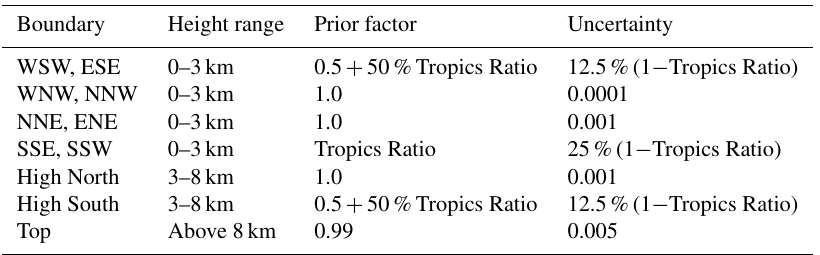
Table 3. Prior multiplying factors for each boundary and their associated uncertainties. See Table 4 for the estimated Tropics Ratios for each